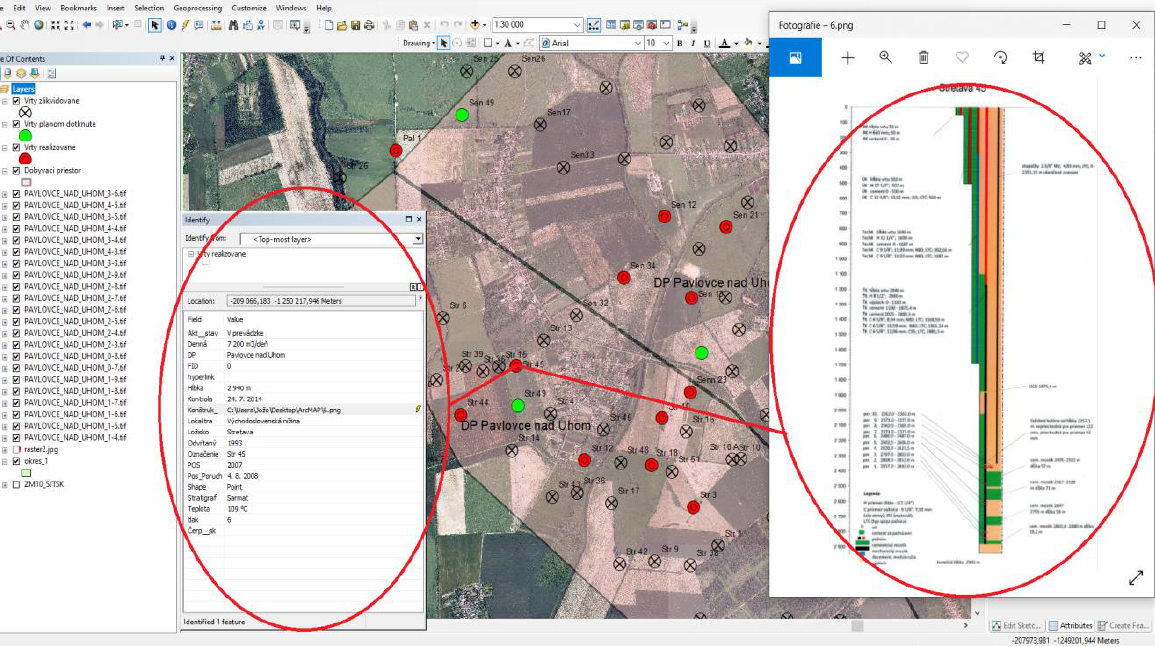
Figure 7. Entering the detected technical specifications and data, (source: elaborated by authors).